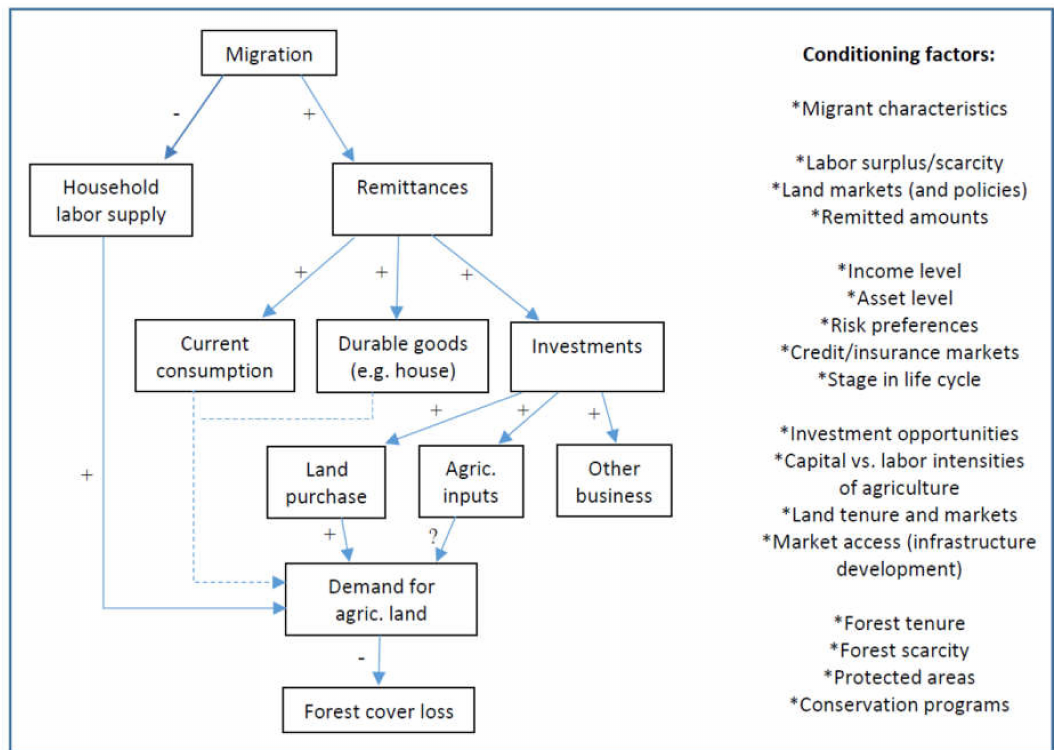
Figure 1. The migration–forest framework. Note: Dotted lines indicate potentially important channels of impact, which are not discussed further in this paper. Conditioning factors are grouped based on their relevance to the decisions or outcomes to the immediate left in the